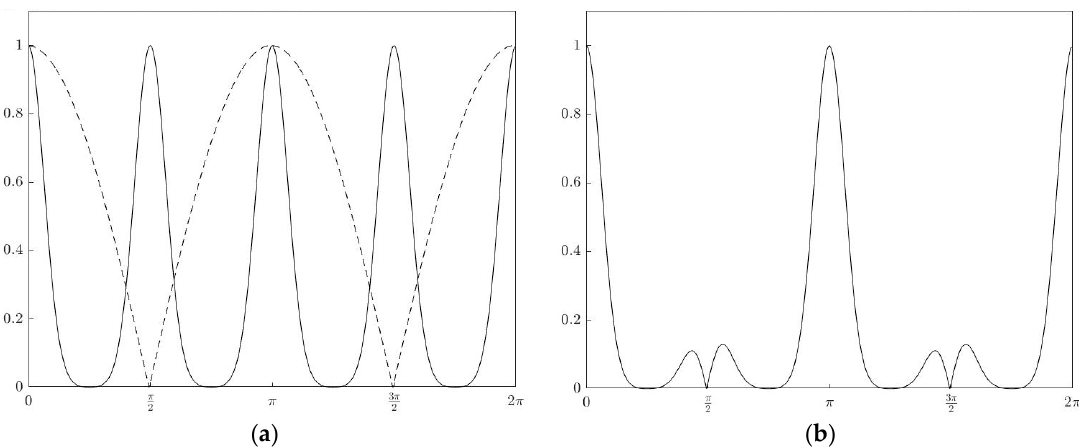
τ = 2 (dotted line), ( b ) frequency = 2 (dotted line), ( b ) frequency (cid:2870) 2